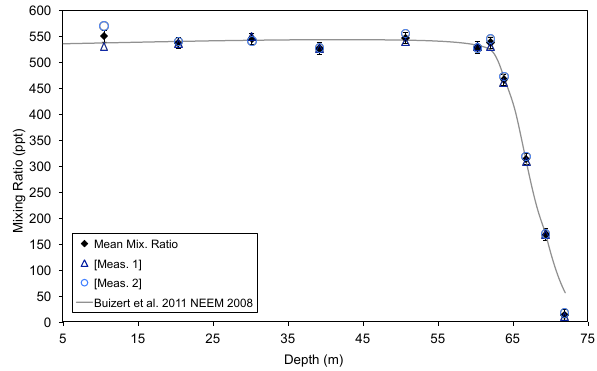
Fig. 5. Age (prior to 2009) distribution in the firn air column as a function of depth from the forward model. Red diamonds indicate sampling depths for